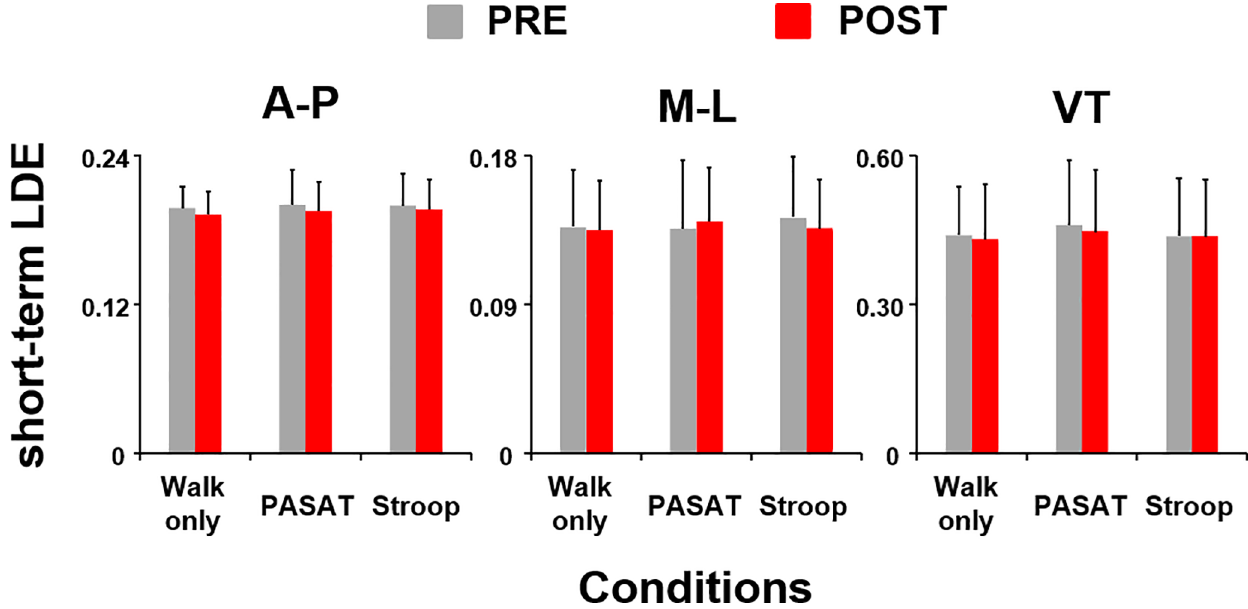
Fig 1. Short-term LDE. Short-term LDE, indicating local stability of the C7 vertebral marker movement, in the anterior-posterior, medio-lateral, and vertical directions before (PRE, grey bars) and after (POST, red bars) the muscle fatiguing exercise session. Error bars represent 1 STD.